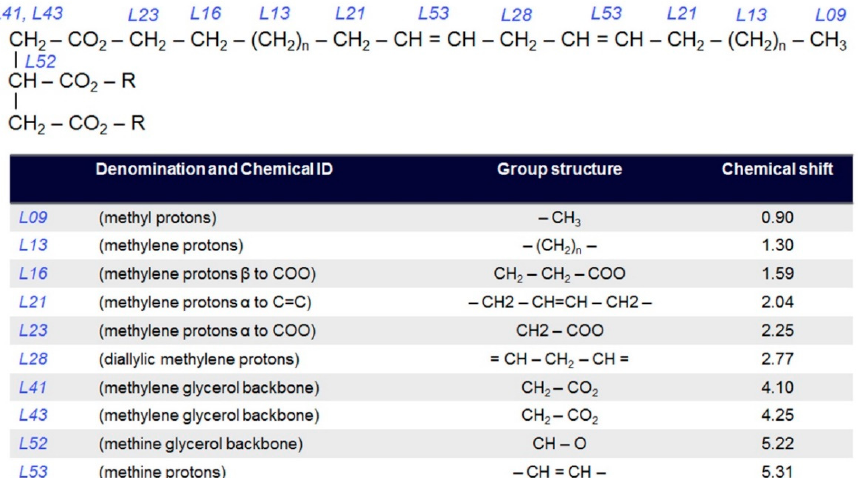
Figure 2. Chemical structure and list with expected resonances in lipids. Adapted with permission from ref. [24]. Copyright © 2011 copyright John Wiley and Sons.